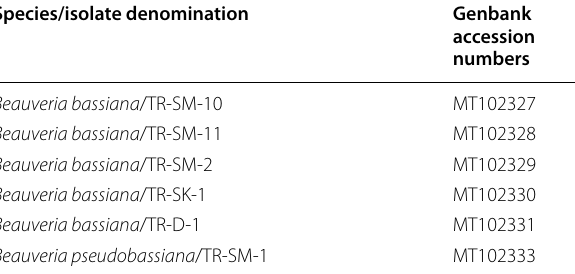
Table 1 Species of the entomopathogenic fungi isolates used in the